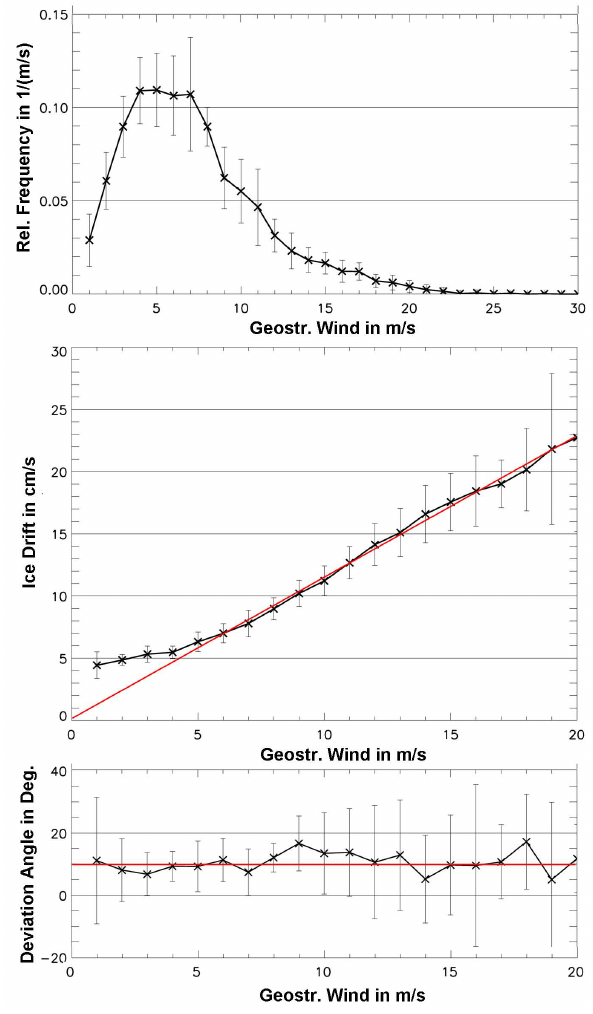
Fig. 8. Frequency distribution of geostrophic wind (top) and vari- ation of magnitude of ice-drift velocity (middle) and deviation an- gle between ice velocity and geostrophic wind (bottom) for various magnitudes of the geostrophic wind based on all 16 Damocles 2007 buoys for the period 1 May to 30 September